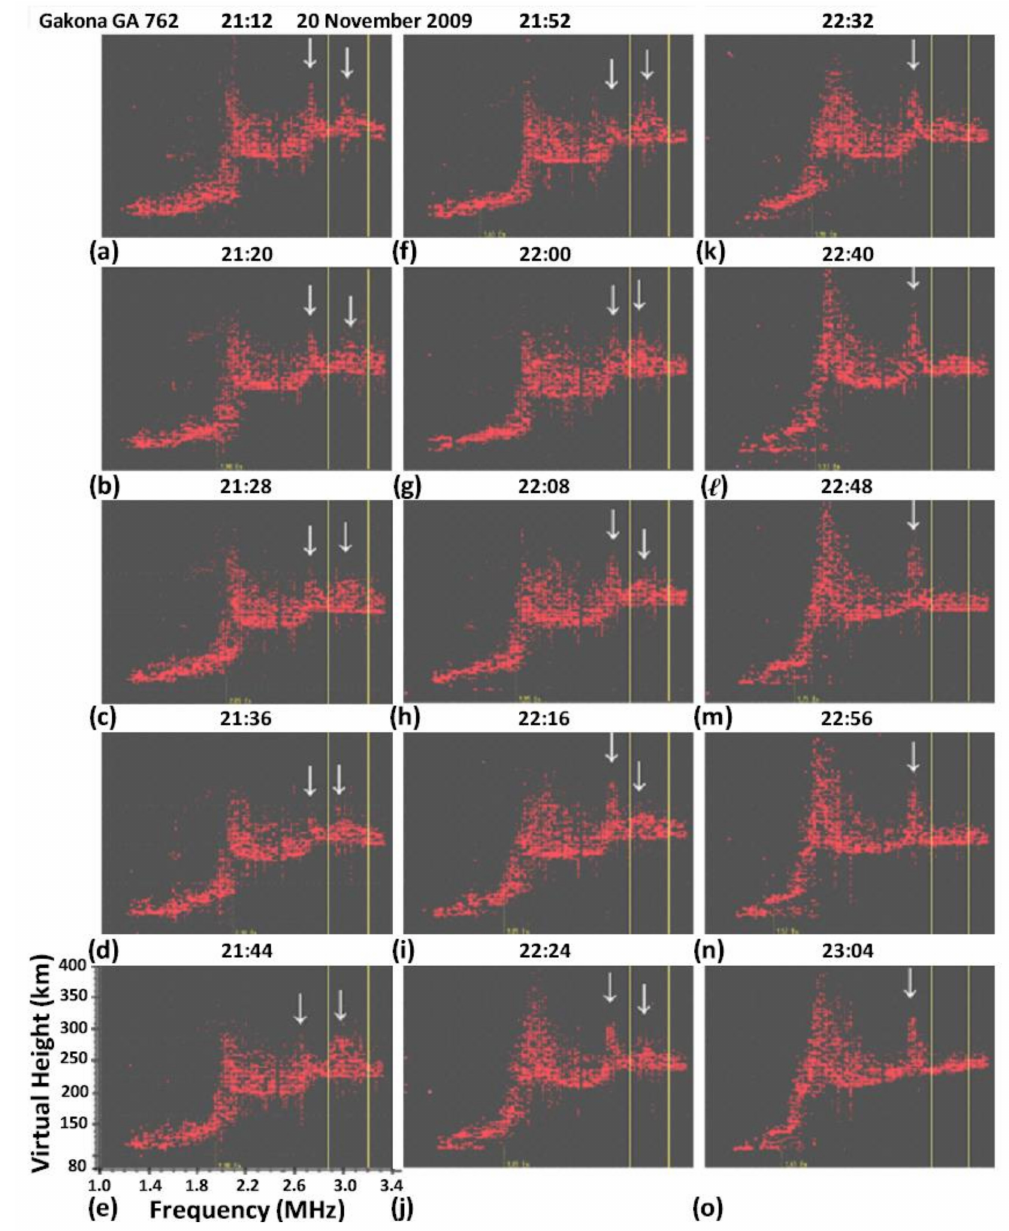
Figure 2. A sequence of ionograms ( a – o ) showing the evolution of the virtual height spread. Arrows locate the likely bumps in the virtual height spread and the two lines at 2.88 MHz and 3.2 MHz label the plasma frequencies of the upper hybrid resonance layer and high frequency (HF) reflection